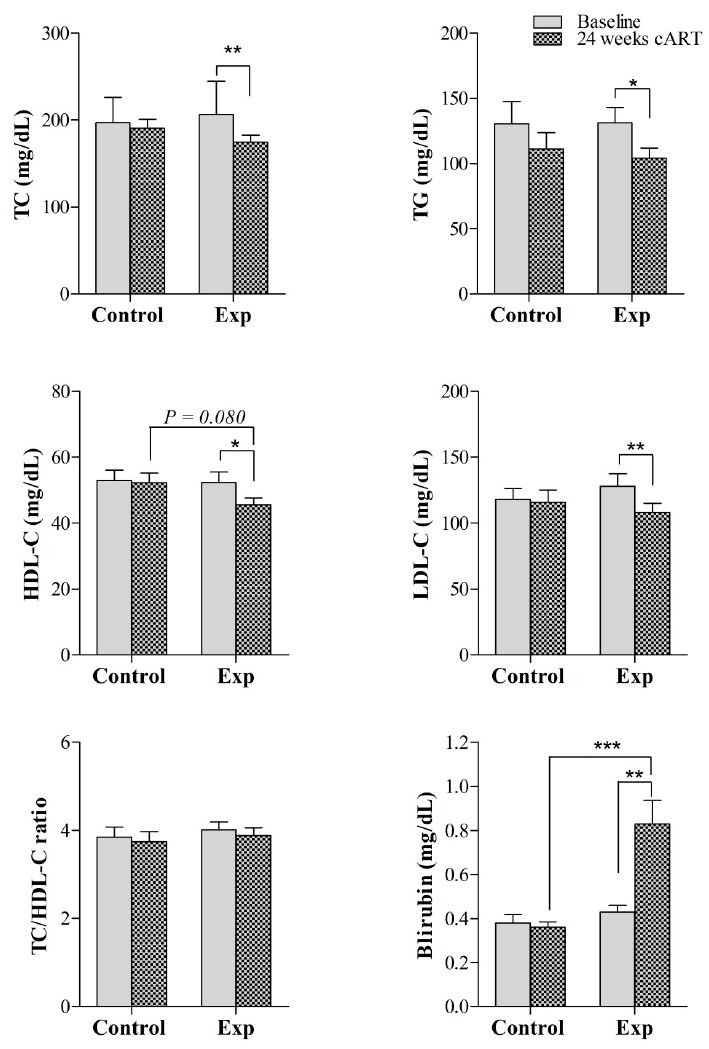
Figure 2. Evaluation of the effect of switching to RPV versus maintaining EFV both co-formulated with FTC / TDF on conventional clinical parameters at baseline and at 24 weeks of follow-up. Data are presented as the mean ± SEM. * p -value < 0.05, ** p -value < 0.01, and *** p -value < 0.001. Abbreviations: Exp, experimental group; RPV, rilpivirine; TC, total cholesterol; TG, total triglycerides; LDL-c: low-density lipoprotein cholesterol; HDL-c: high-density lipoprotein